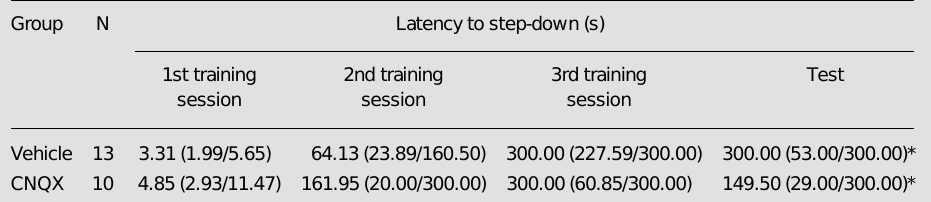
Table 2 - Median (interquartile range) of latencies to step-down of rats submitted to three training and one test session (24-h interval between training sessions, 48-h interval between third training and test session) in a step-down inhibitory avoidance task (0.2-mA footshock). Animals received bilateral intra-amygdala 0.5-µl infusions of vehicle (25% DMSO in saline) or CNQX (0.5 µg) 10 min prior to the test. *P<0.01 for comparison among consecutive sessions by Friedman two-way analysis of variance. There were no differences between groups (P>0.10, Mann-Whitney test). Group